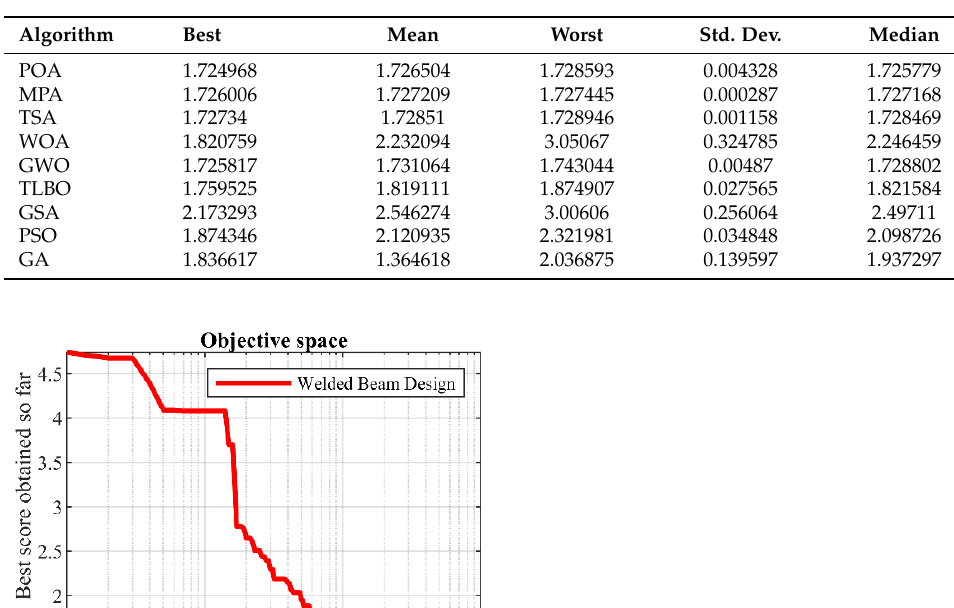
Table 14. Statistical results for welded beam design problem.